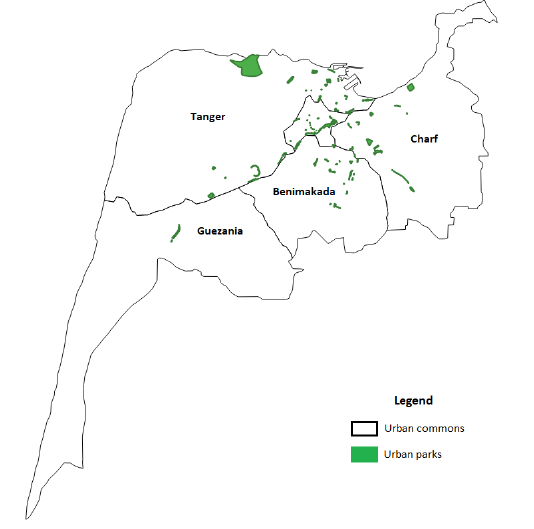
Figure 2 . Spatial Distribution of urban